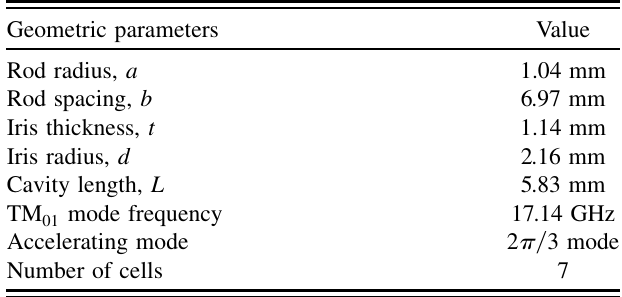
TABLE I. Dimensions of the PBG structure. Geometric parameters